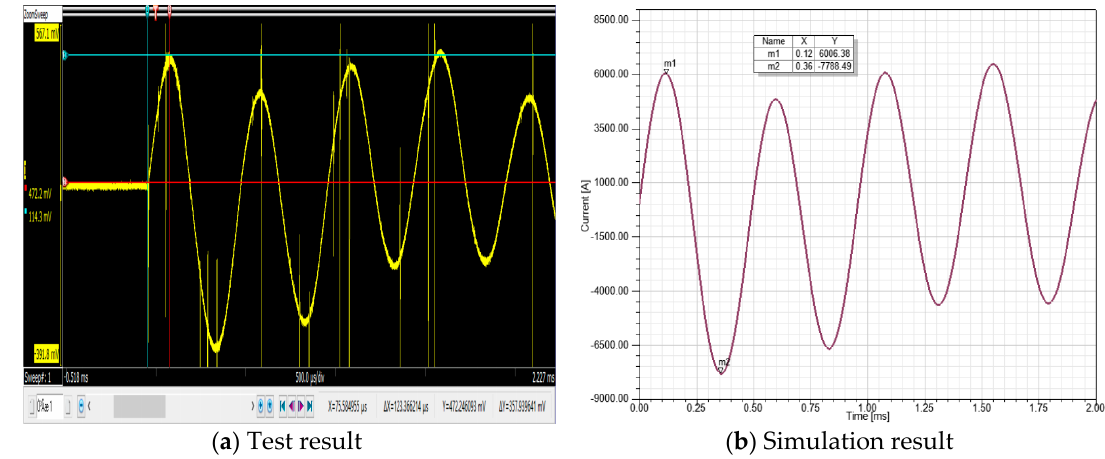
Figure 9. The test and simulation results of the secondary side current.